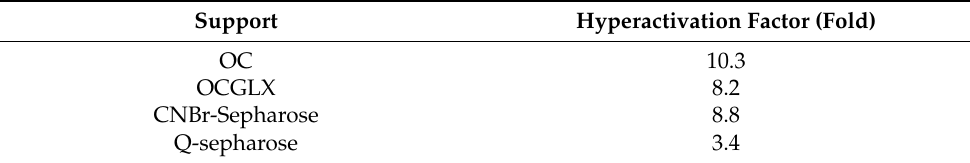
Table 1. Hyperactivation values during immobilization of USBA-GBX-513 lipase on different acti- vated